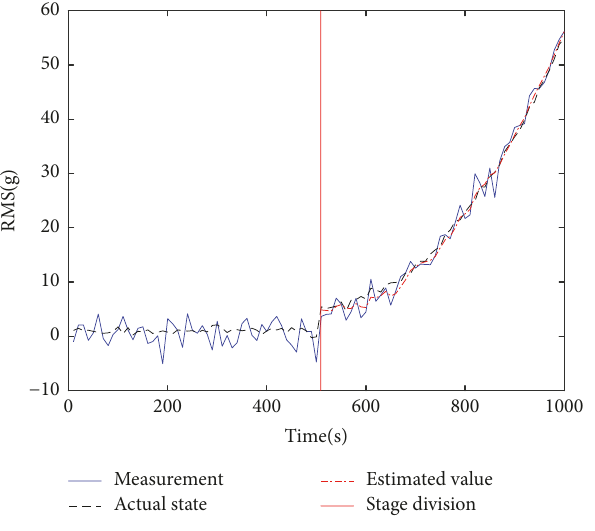
Figure 5: RUL prediction